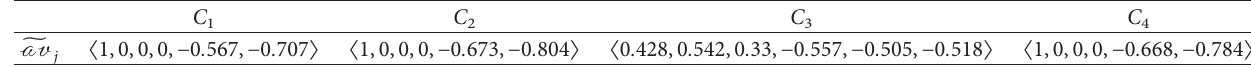
Table 8: The average solution matrix AV .